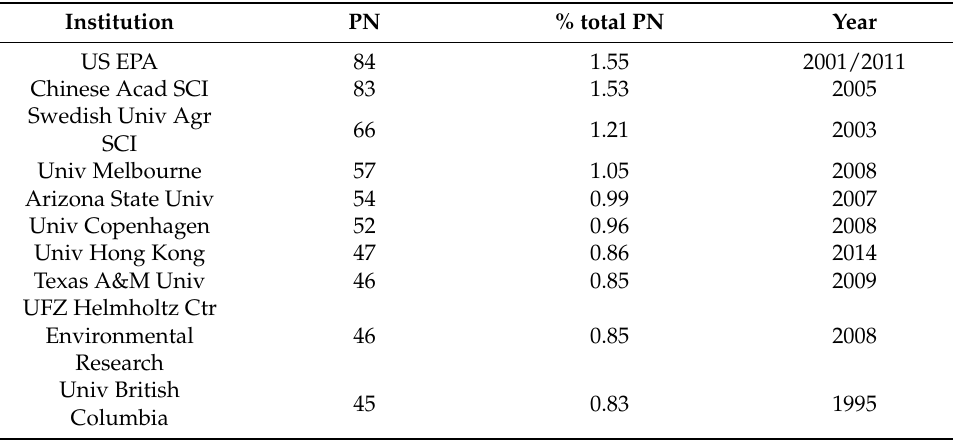
Figure 9. Distribution of top 20 institutions. Table 3. Top 10 institutions by number of publications.